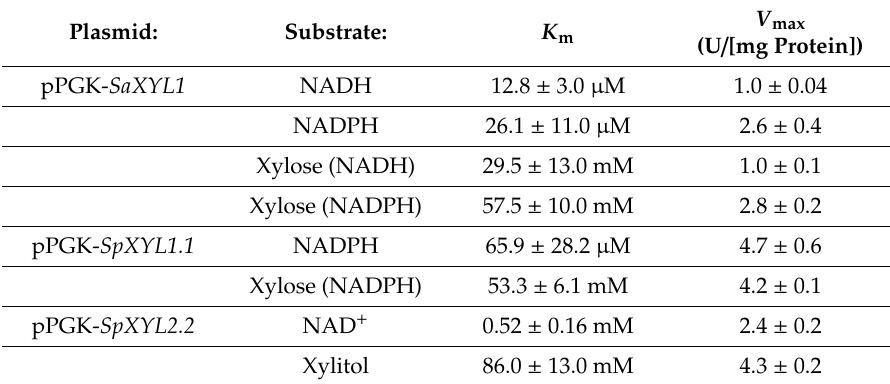
Table 4. Kinetic parameters of the xylose reductase and xylitol dehydrogenase encoded by genes SaXYL1 , SpXYL1.1 , and SpXYL2 . 2 expressed in S. cerevisiae